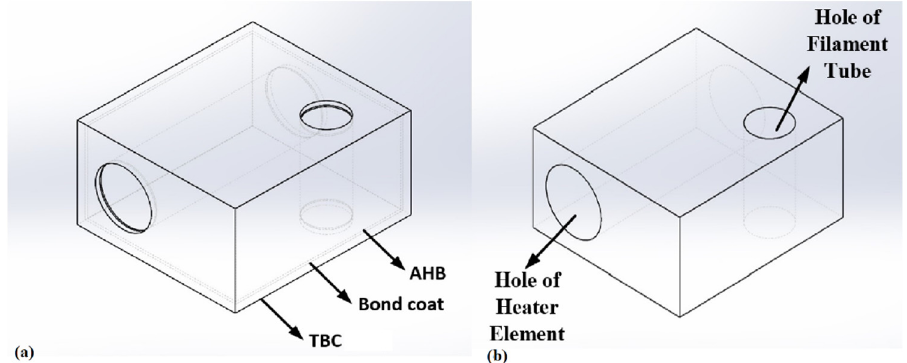
Figure 4. ( a ) The coated and ( b ) uncoated AHB models.